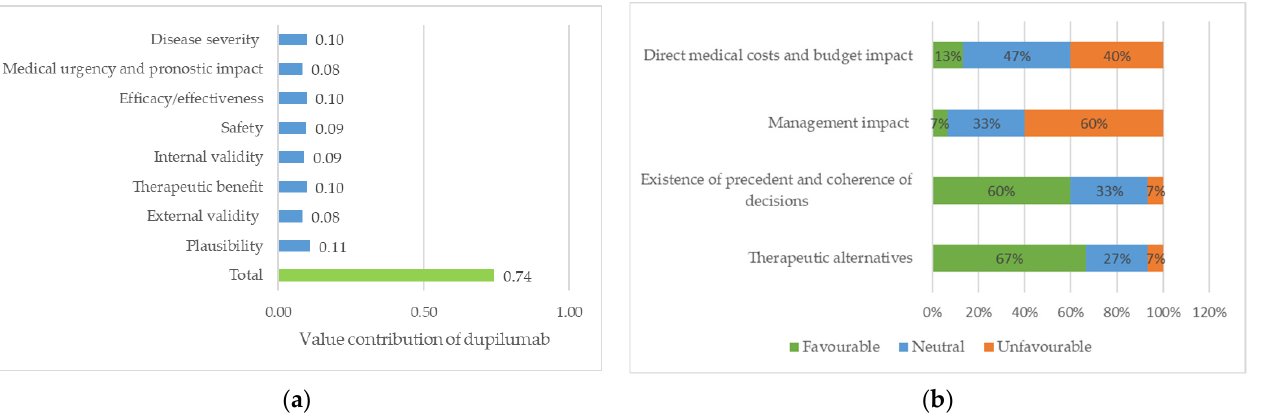
Figure 3. Dupilumab for the treatment of a paediatric patient with severe atopic dermatitis: ( a ) value of contribution of quantitative criteria; ( b ) impact of qualitative criteria (percentage of members who assigned a favourable, neutral and unfavourable).